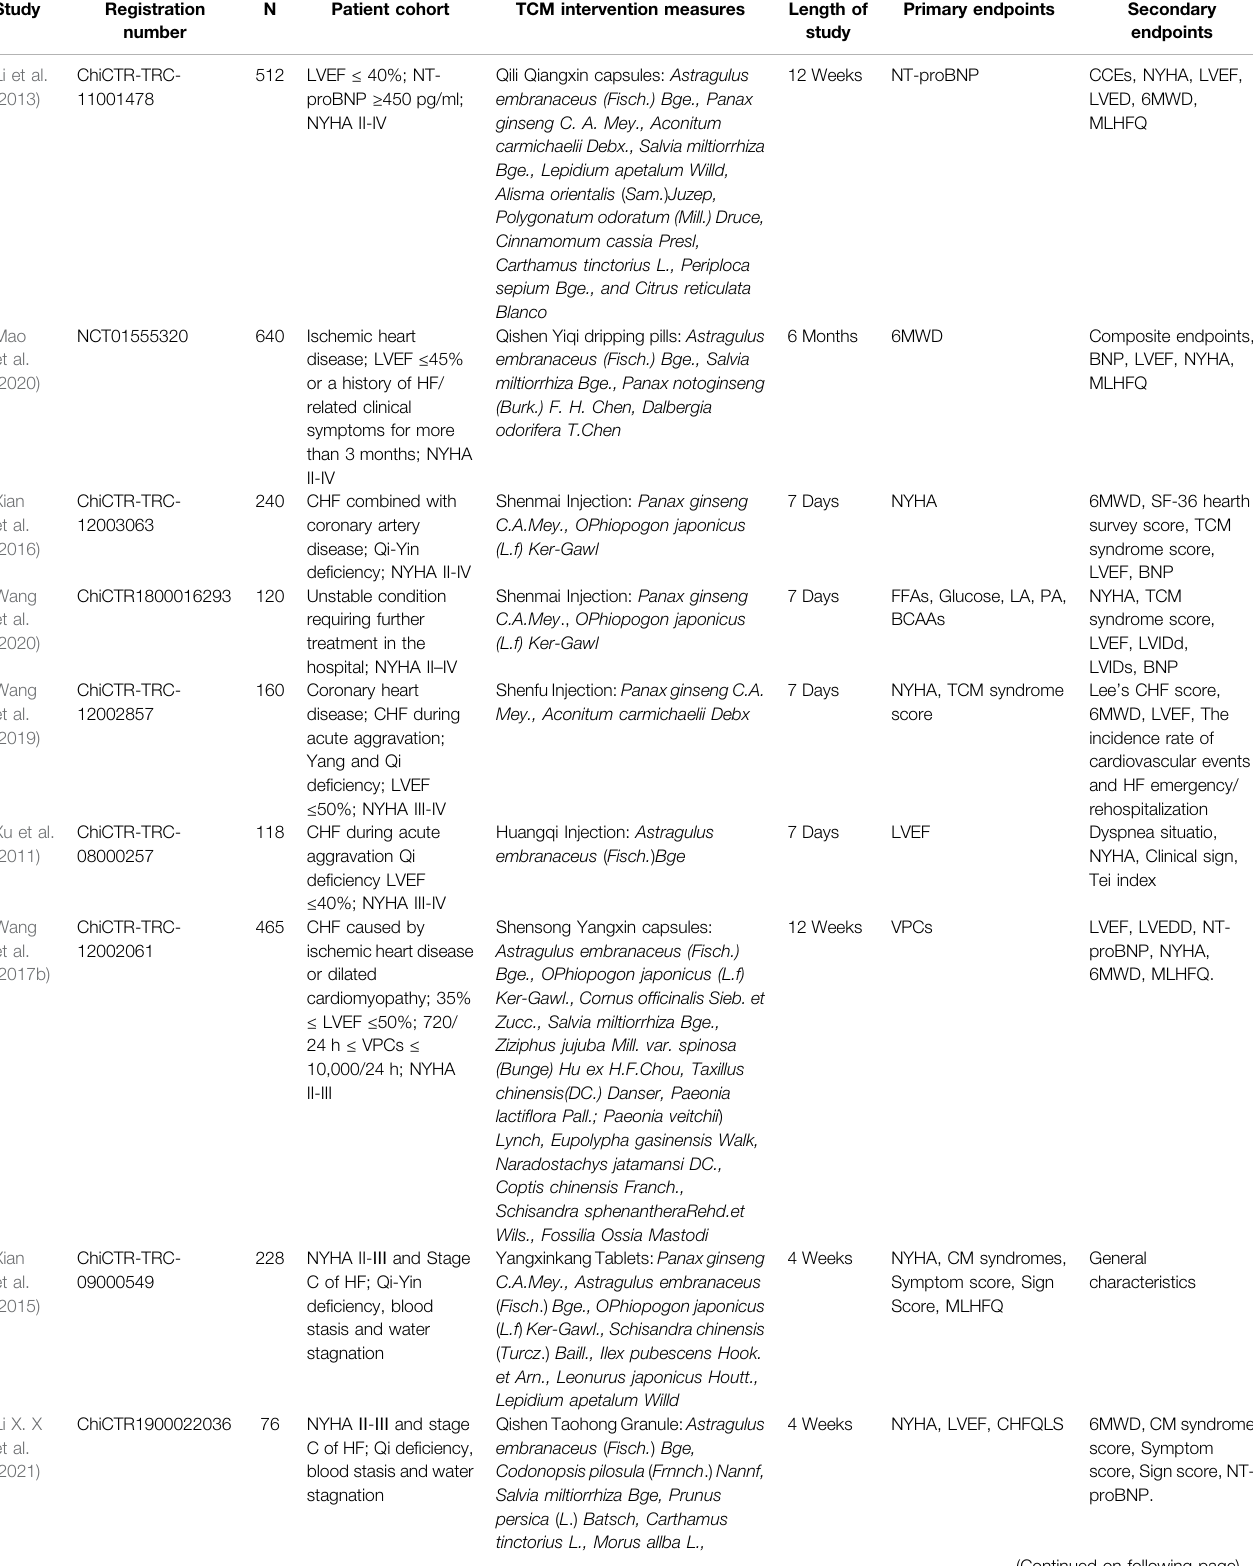
TABLE 1 | Clinical studies of TCM to treating